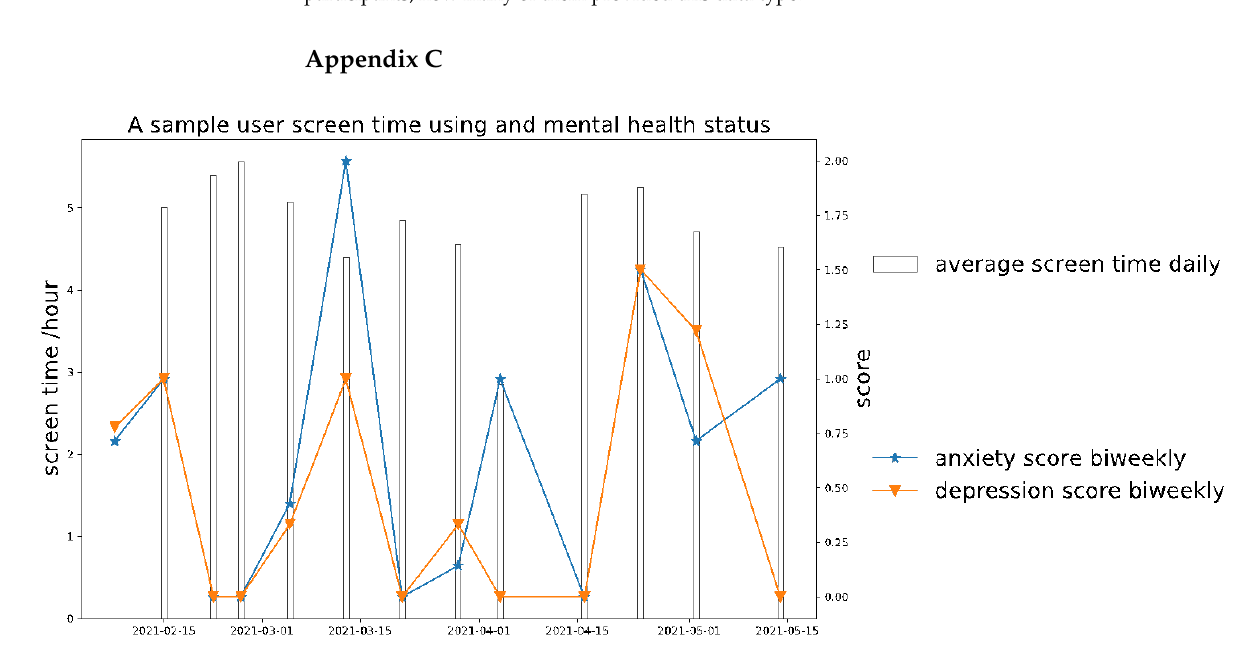
Figure A2. Sample User Mental Health Status Change